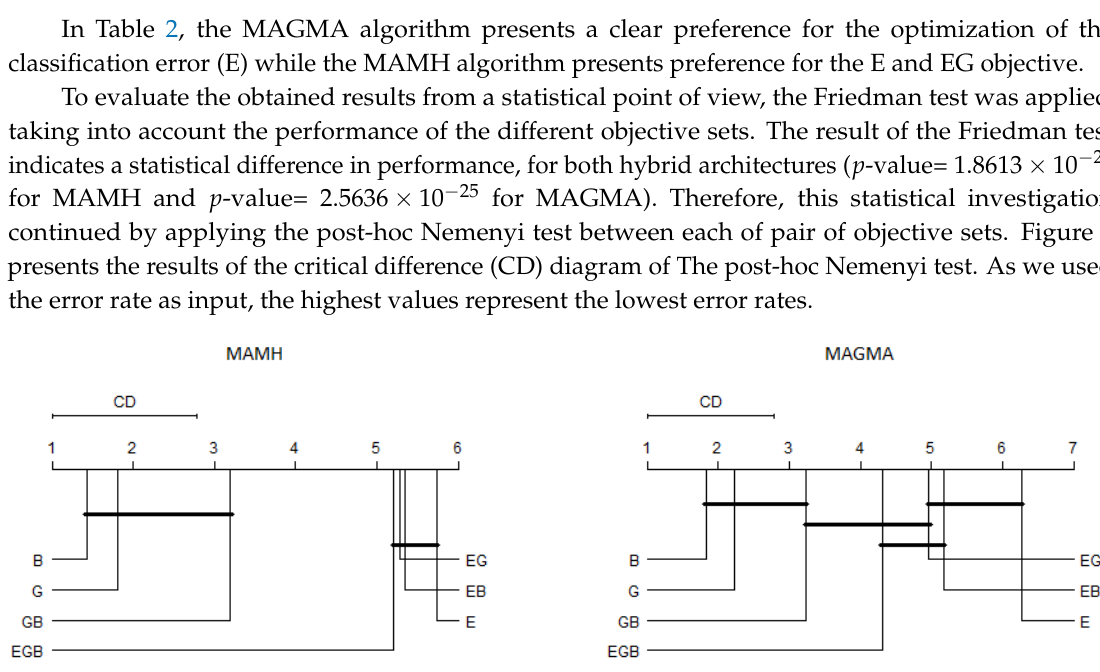
Figure 2. The critical difference diagrams of the post-hoc Nemenyi test on sets of optimization